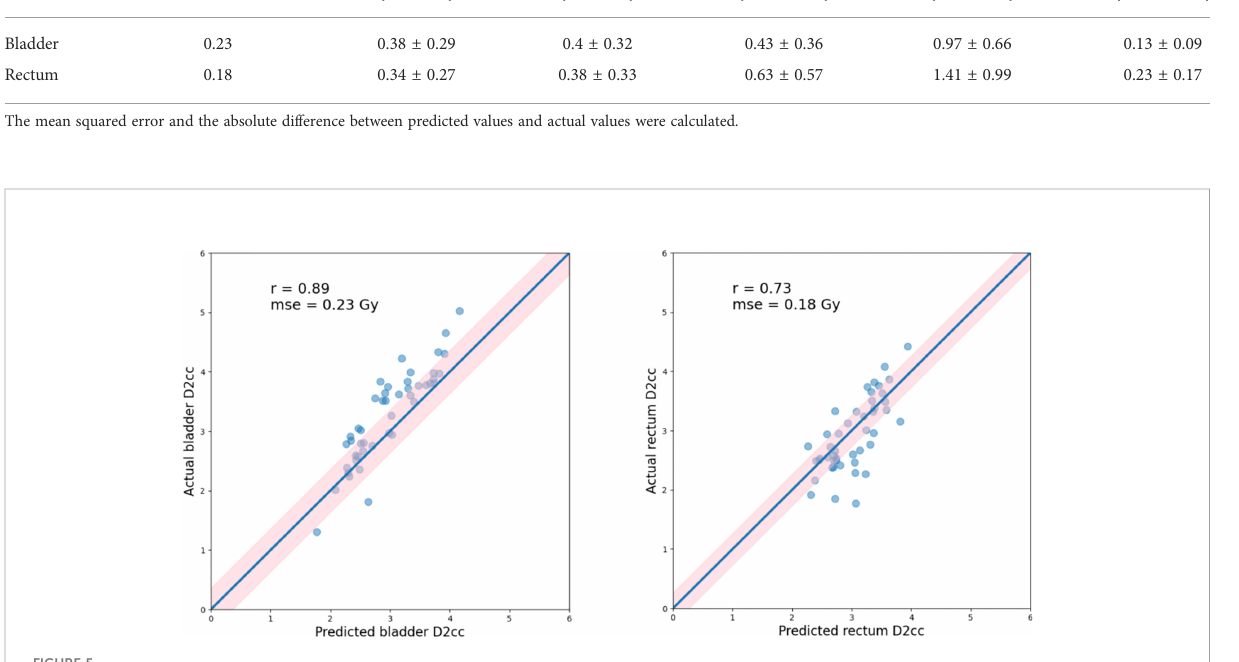
FIGURE 5 Actual vs. predicted D2cc for the bladder(left) and rectum(right), as well as the Pearson correlation coef fi cients (r), standard deviation (indicated by s as well as light pink shaded area). Blue lines indicate the theoretically ideal predictions.